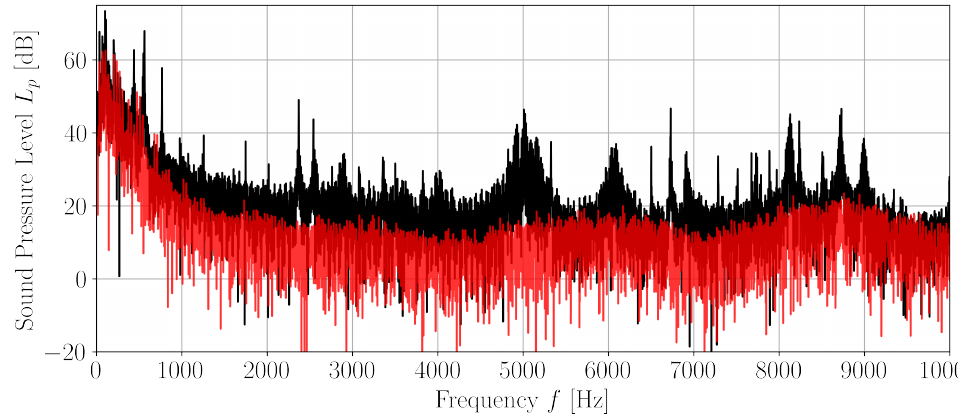
Figure 12. Sound pressure level of cavity noise with flexible polypropylene walls ( ).